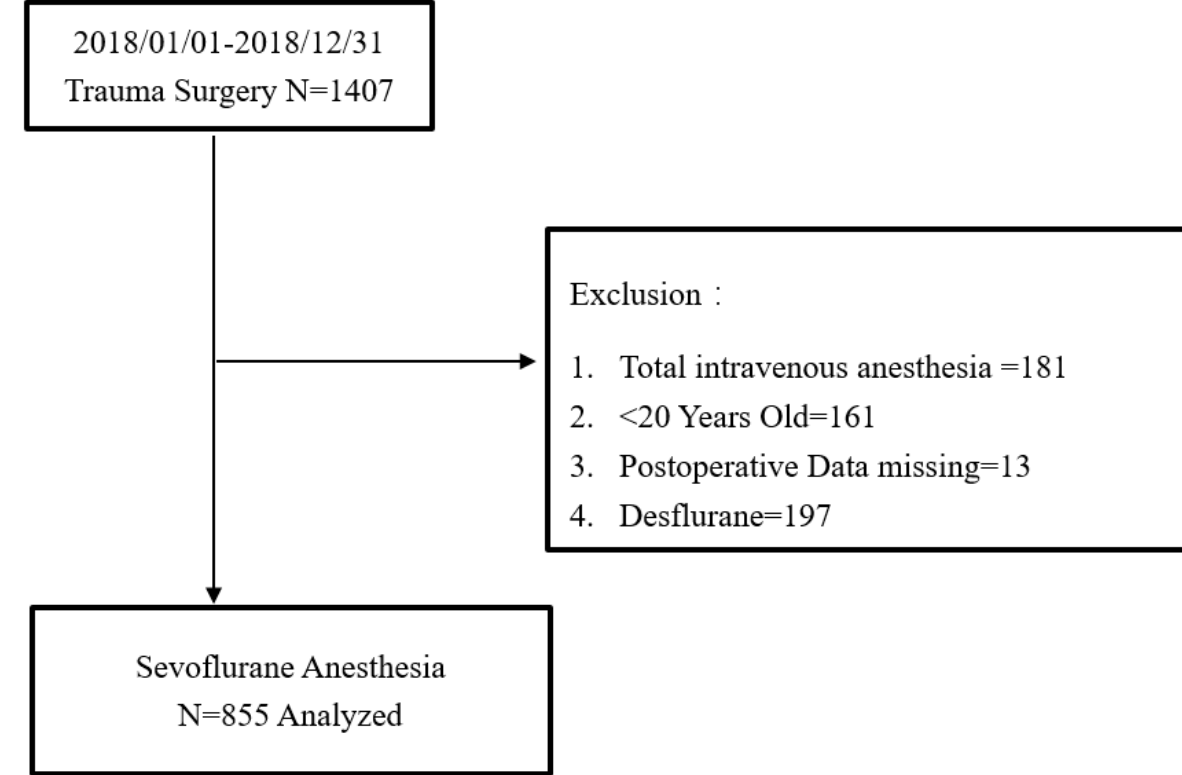
Figure 1. Flow diagram of our surgical trauma patients by sevoflurane ‐ based general anesthesia.